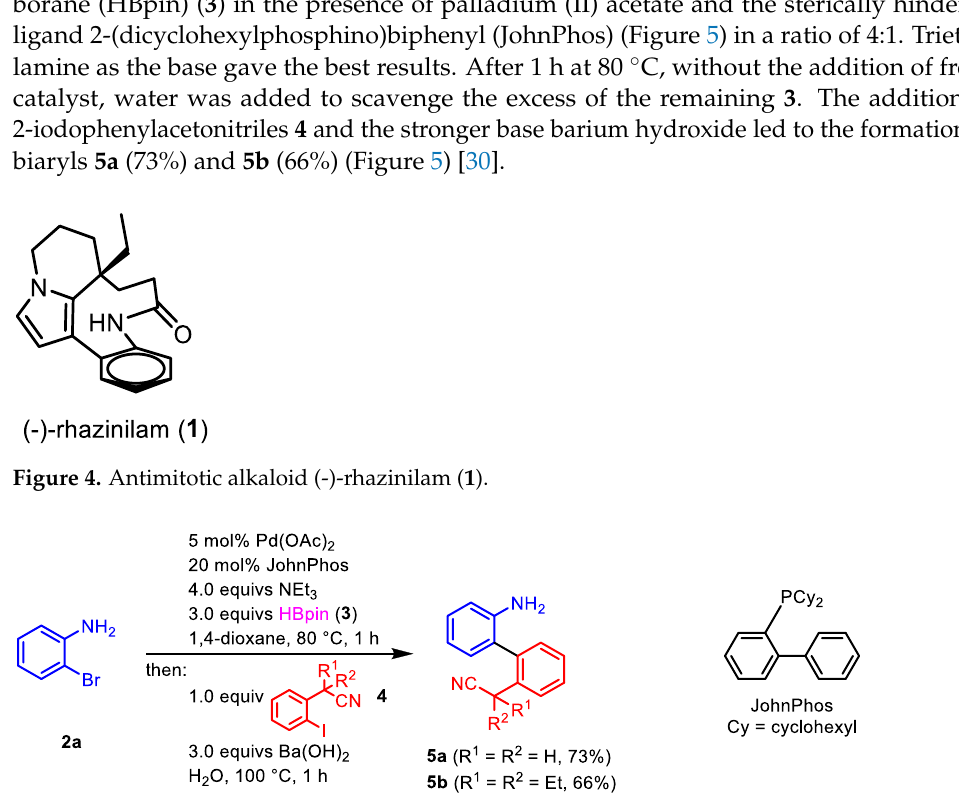
Figure 4. Antimitotic alkaloid (-)-rhazinilam ( 1 ).